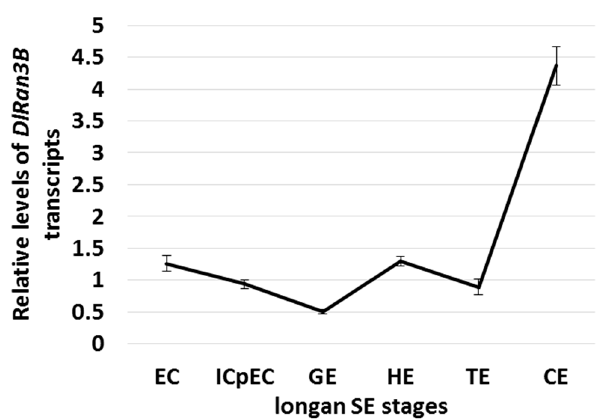
Figure 2. DlRan3B expression pattern in longan somatic embryogenesis (SE). Longan SE stages include embryogenic callus (EC), incomplete compact pro-embryogenic cultures (ICpEC), globular embryo (GE), heart-shaped embryo (HE), torpedo-shaped embryo (TE), and cotyledon embryo (CE). The DlRan3B expression level was normalized to those of EF-1a , eIF-4a , and DLFSD1a . Data are shown as means ± SD ( n = 3).